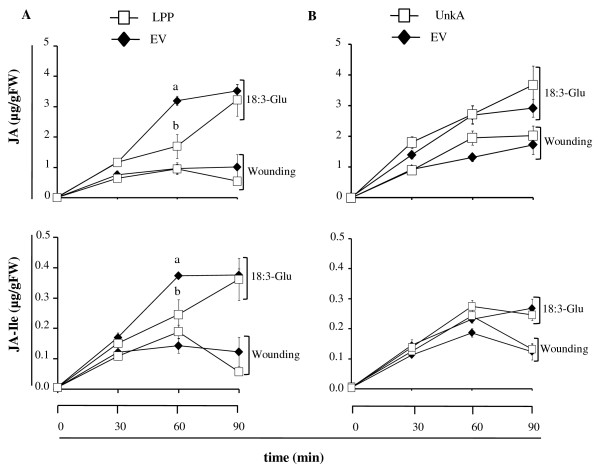
Quantification of JA and JA-ILE levels in LPP- and UnkA-silenced plants. Leaves from N. attenuata plants silenced in the expression of LPP and UnkA by VIGS were either wounded or 18:3-Glu elicited and tissue was harvested at different times. A, Mean (± SE) JA and JA-ILE levels in EV and LPP-silenced plants (n = 5). Statistical differences in JA and JA-ILE levels were analyzed by univariate ANOVA (JA, F3,12 = 18.6, P < 0.001; JA-ILE, F3,12 = 5.6, P < 0.05). Different letters denote significant differences in a Scheffé post-hoc test at P < 0.05. B, Mean (± SE) JA and JA-ILE levels for EV and UnkA-silenced plants (n = 5).